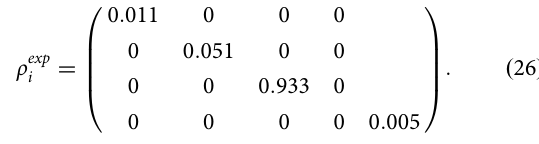
ffiffiffiffiffiffiffiffiffiffiffiffiffiffiffiffiffiffiffiffiffiffiffiffiffiffiffiffi ffiffiffiffiffiffi p ρ th